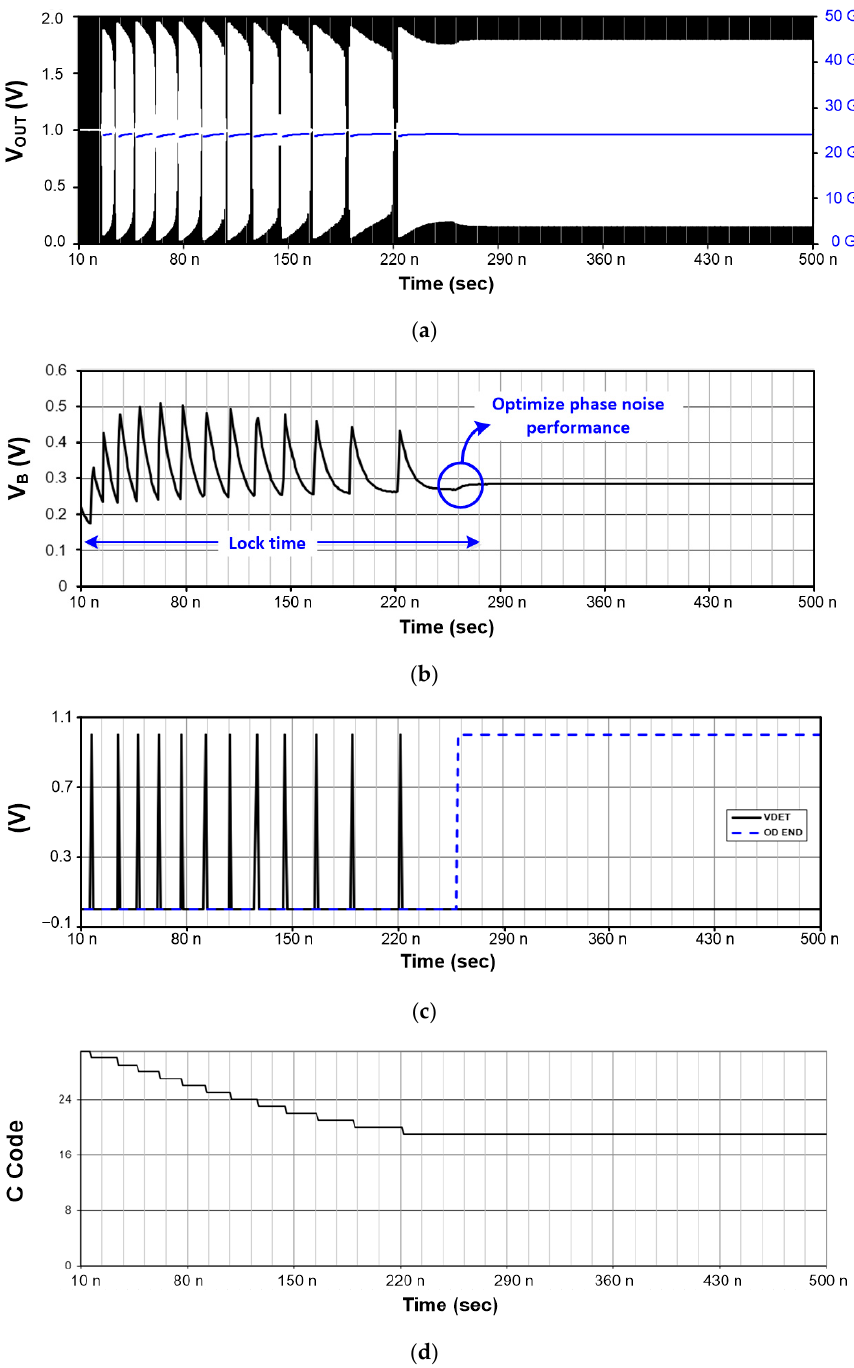
Figure 5. This figure is the simulation result of the proposed class-C VCO. It is the result of output ( a ) voltage V OUT , output frequency F OUT , ( b ) gate bias V B , ( c ) OD output V DET and END signal and ( d ) 5-bit digital to analog converter (DAC) output.